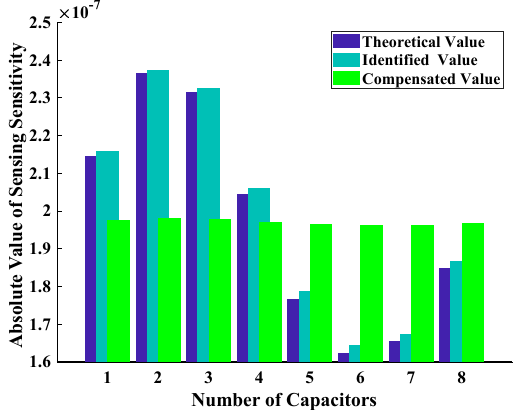
Figure 14. Absolute Value of Sensitivity of Each Capacitor for Eight-Electrode Type HRG.